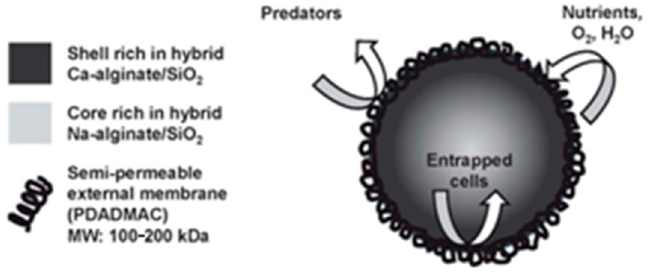
Figure 17. Schematic illustration of the biotemplating synthesis of biomorphic hollow structures via the surface sol-gel process. Reprinted with permission from [130].